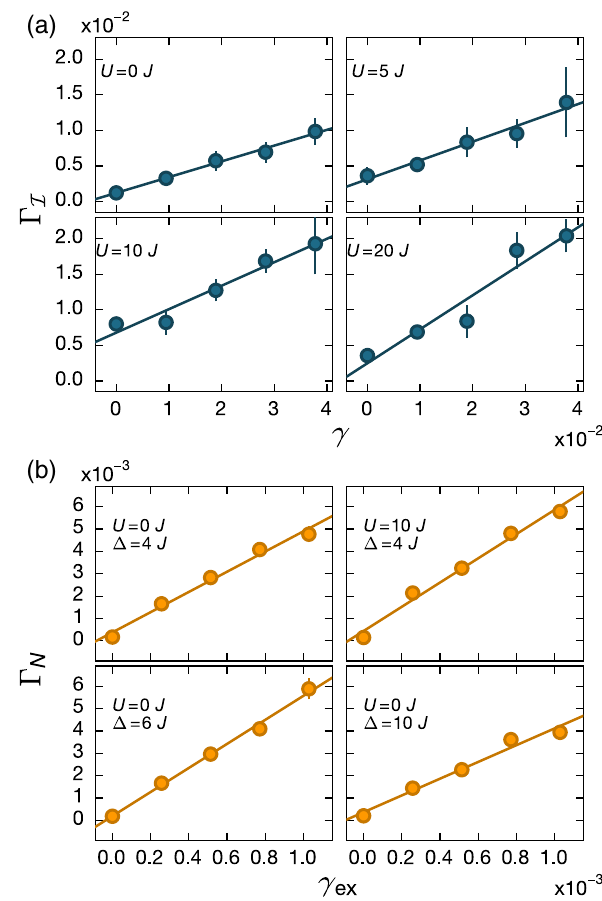
FIG. 9. Imbalance and atom number decay rate as a function of the scattering rate. (a) Imbalance decay rate for various inter- action strengths at Δ ¼ 4 J . Our data are consistent with a linear behavior for all parameter values. The imbalance decay rates additionally show a background decay rate at γ heavily depends on both the interaction and the disorder strength. (b) Atom number decay rates as a function of the band-excitation rate. Again, we find a linear